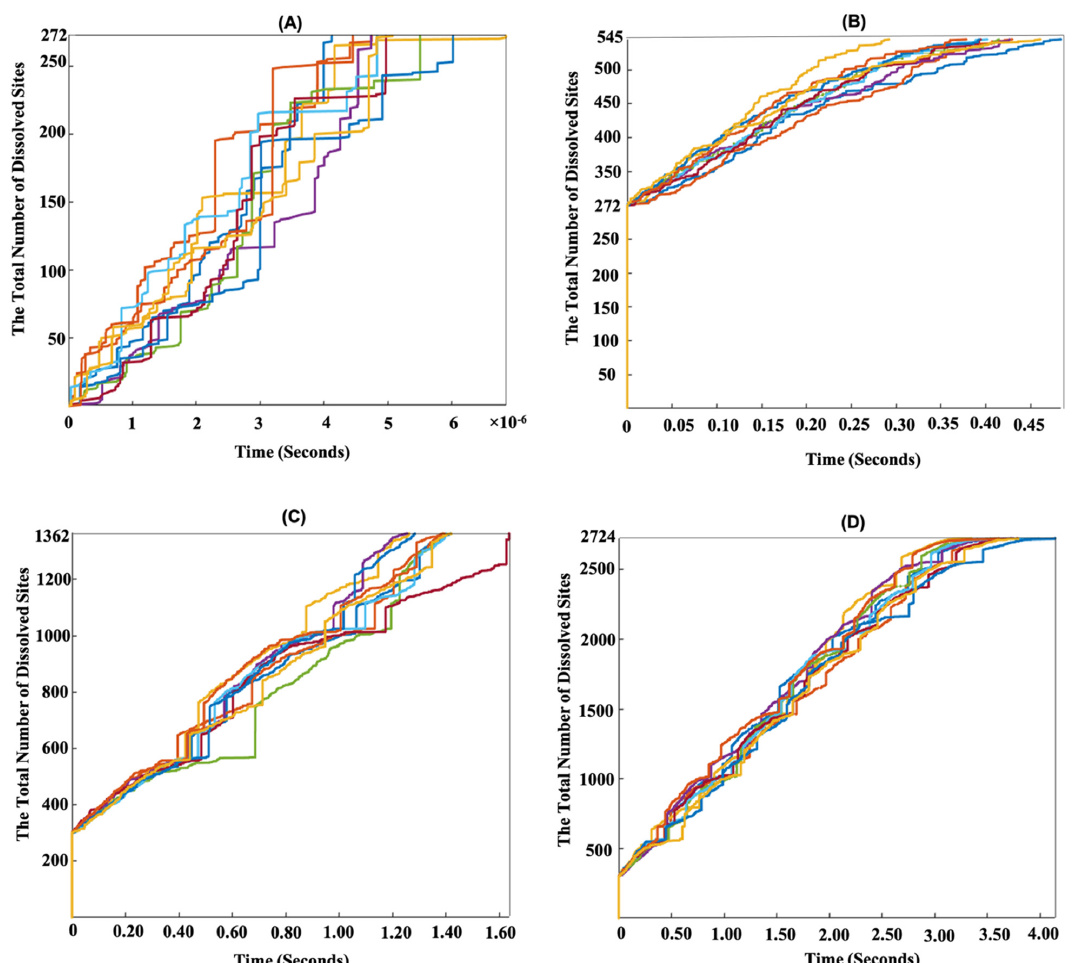
Figure 5. Time evolution of site dissolution for β -C 2 S crystal by applying periodic boundary condi- tions (PBCs) along the Z axis (defect border is applied along one axis) for 10 numerical realizations (displayed with different colors) on the (100) and (100 ) facets. ( A – D ) After dissolution of 272, 545, 1362, and 2724 sites representing 10%, 20%, 50%, and 100% of the total number of crystal sites of the initial structure, respectively.